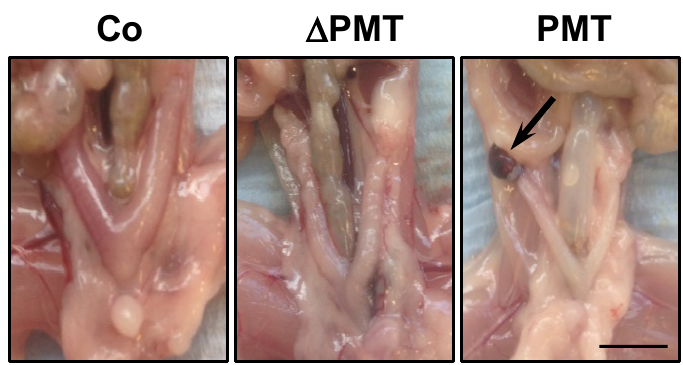
Figure 3. Gross pathology of PMT-treated mice. Representative dissections of mice treated with PMT (3 ng), mutant PMT ( ∆ PMT; 3 ng) or vehicle control (Co) for one month showing a lesion resembling a hemorrhagic cyst (arrow) in PMT-treated mice. Scale bar: 5